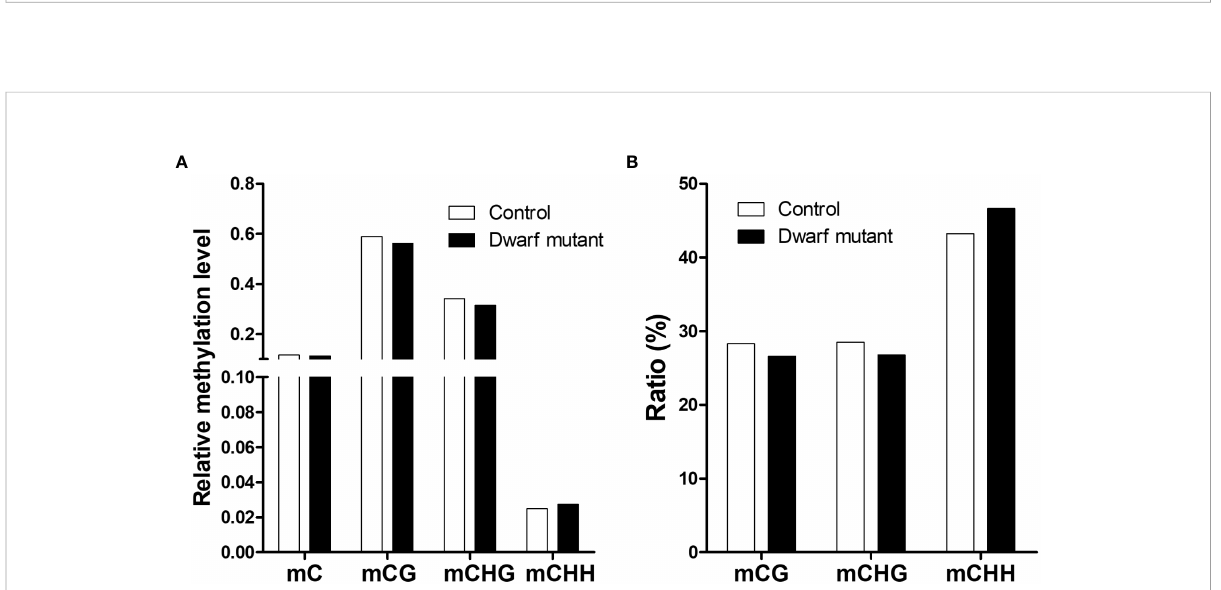
FIGURE 5 Genome-wide methylation status in dwarf mutant and control. (A) Relative methylation level de fi ned as the ratio of methylated cytosines to total cytosines in each context. (B) Ratio (%) of methylated cytosines in different contexts to total methylated cytosines; genome-wide methylated cytosine is set as 100%. mC, mCG, mCHG, mCHG represents methylated cytosine in C (genome-wide), CG, CHG, CHH context,